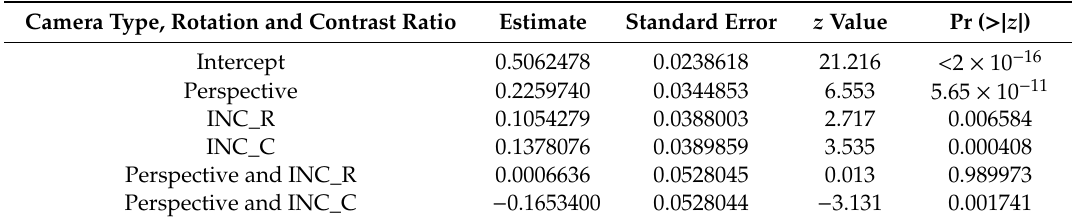
Table 30. Logistic regression analysis results of the additive model using variables camera type, rotation and the contrast ratio and allowing interactions of two